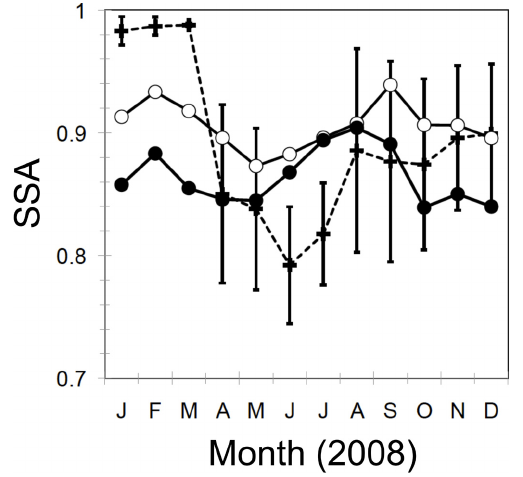
Fig. 9. As in Fig. 8, but for a scatter plot of BC vs.